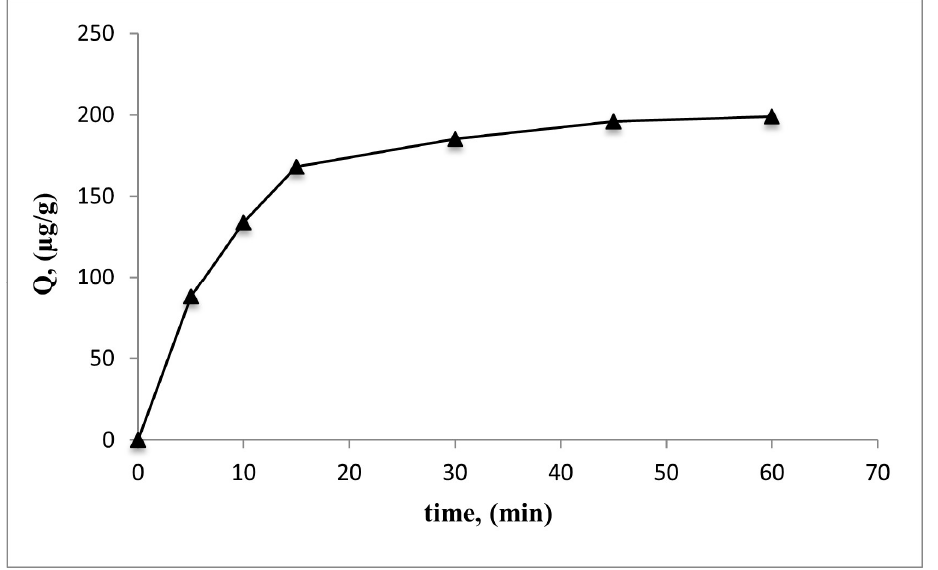
Figure 7. The effect of E2 time on adsorption capacity: ( c 0 : 1.0 mg/mL, pH: 7.0, IS: 0, W particles : 100 mg, t: 25 ◦